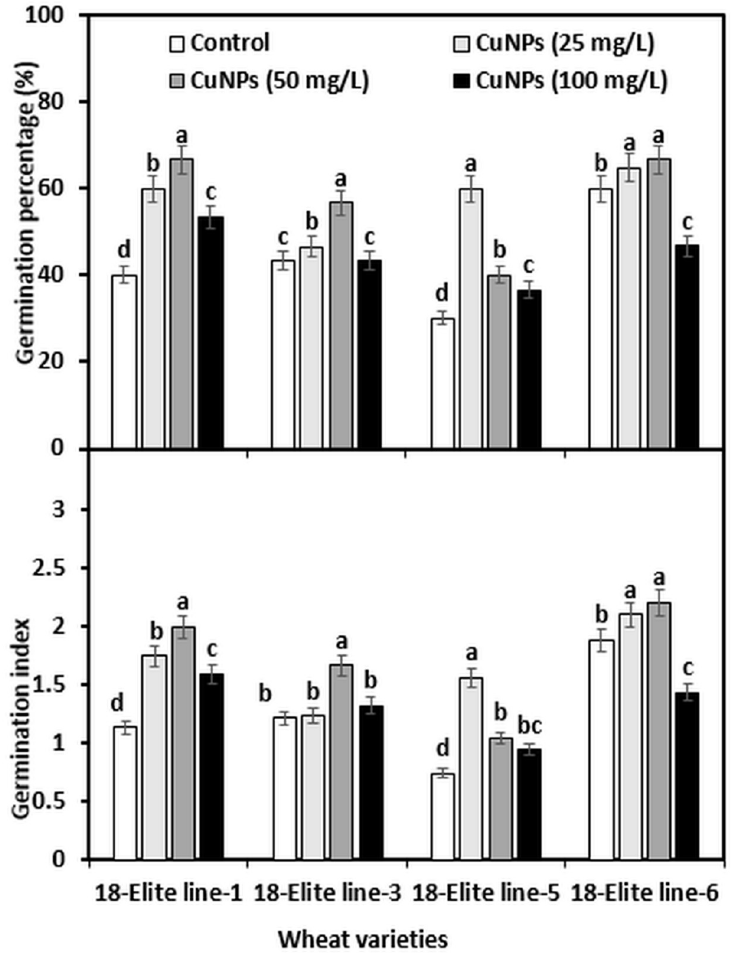
Fig 4. Seed germination percentage and germination index of wheat varieties affected by different concentration of CuNPs. Different letters in the same sub-group of columns indicate significant difference at p < 0.05 level.